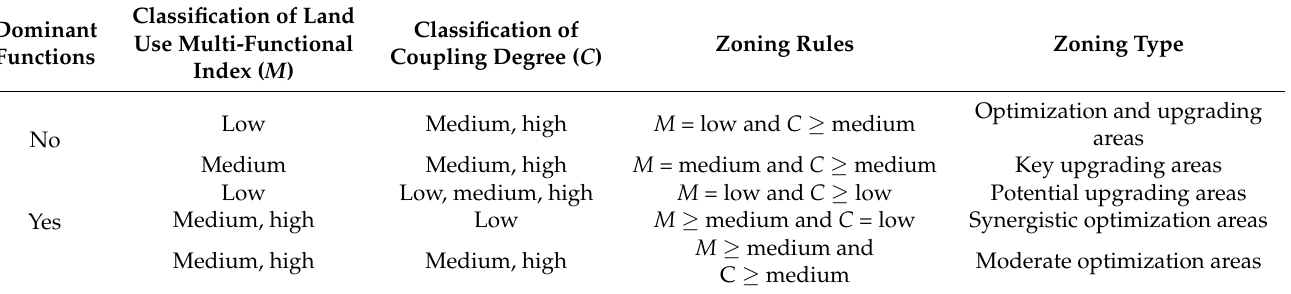
Table 3. Zoning methods for